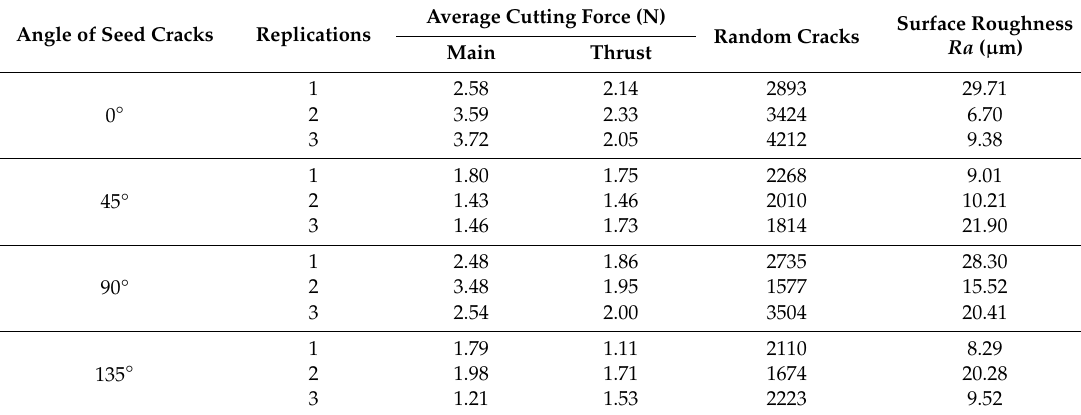
Figure 7. Simulation images of machined workpiece with seed cracks of di ff erent angles: ( a ) 0 ◦ , ( b ) 45 ◦ , ( c ) 90 ◦ , and ( d ) 135 ◦ . Table 6. Simulation results for each condition.